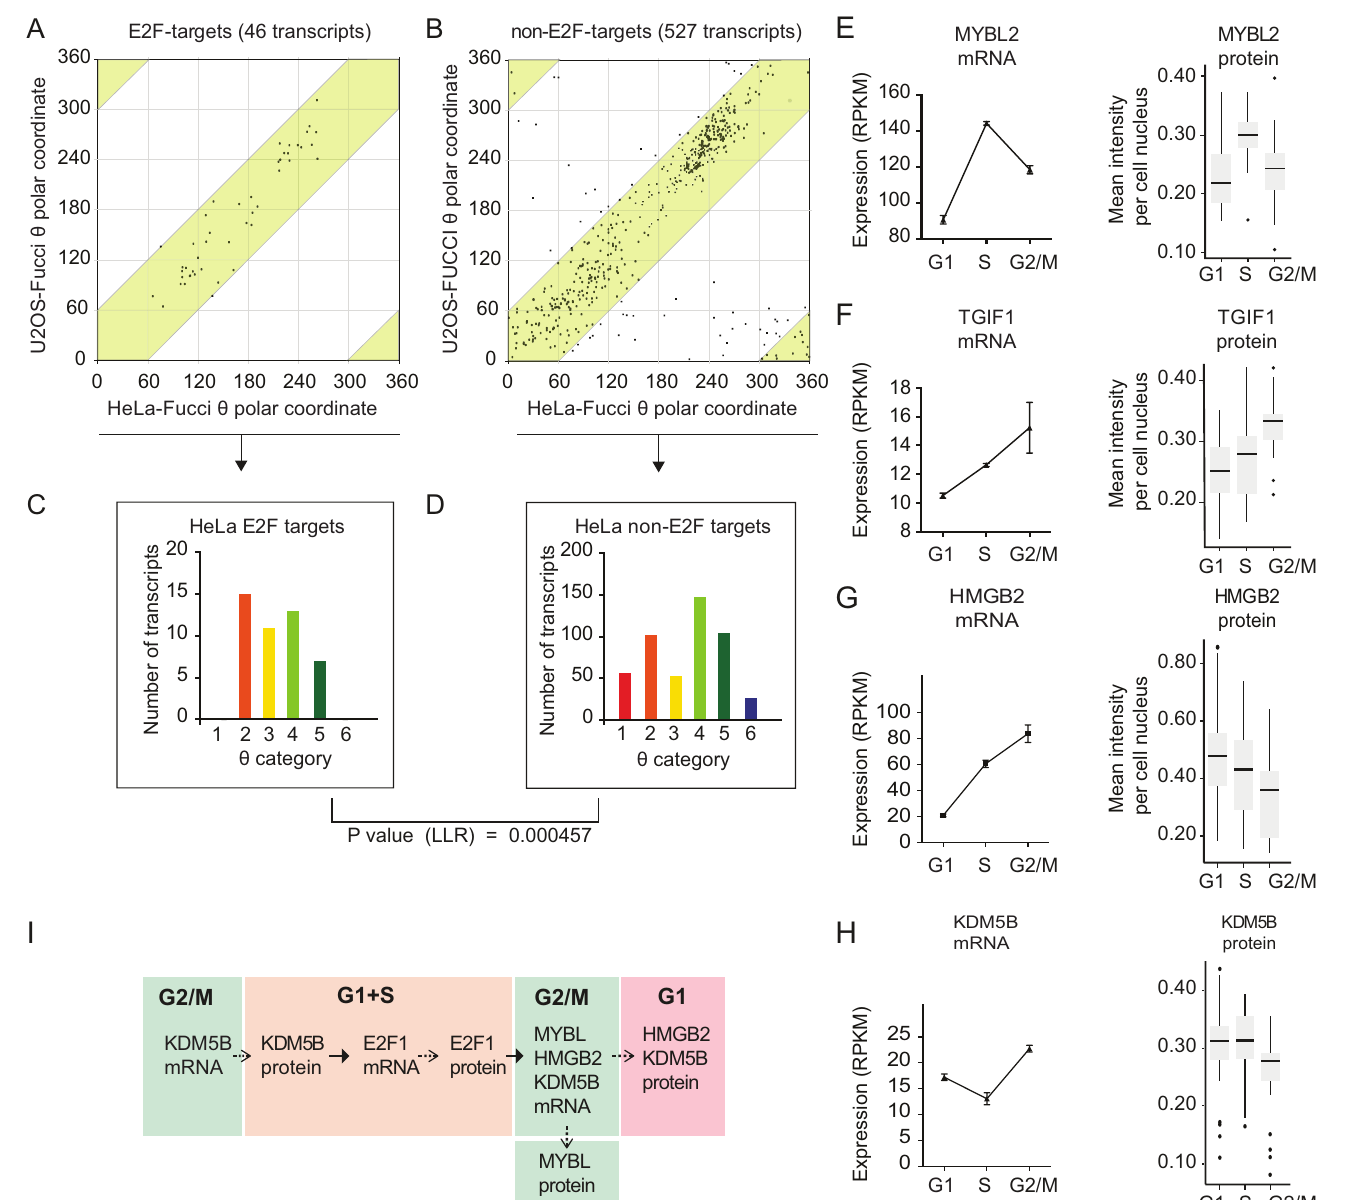
Fig 3. Large TF families oscillate and show differential distribution during the cell cycle. (A-D) θ -valueplots for all TFs and TF families with a significantly differing pattern in (A, C) HeLa-Fucci cells and (B, D) U2OS-Fucci cells (FDR (cid:20) 0.001; logCPM (cid:21) 1; FC (cid:21) 1.5). (E) θ -valueplot of cell-cycle-synchronizedTFs in HeLa-Fucci cells versus U2OS-Fucci cells, with suggestedphase-specific expression groups denotedI-VI and the main TFs involvedin G1 restriction and onset of S phase indicatedin red. (F) Schematic showinghow repressor activity may shapetranscriptionalboundaries duringthe cell cycle, exemplified by E2F7/8 repression of E2F1/2 expression.